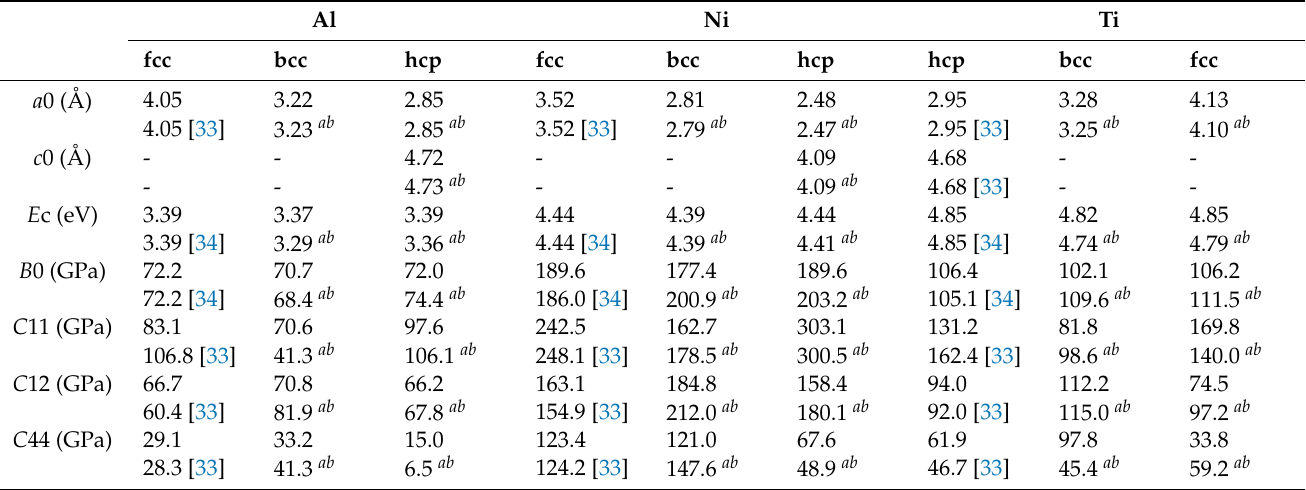
Table 2. Properties of Al, Ni and Ti used for fitting and the reproduced results: lattice constants ( a 0 and c 0), cohesive energy ( E c), bulk modulus ( B 0) and elastic constants ( Cij ). ab indicates that the data were calculated by first-principle calculations in this work.